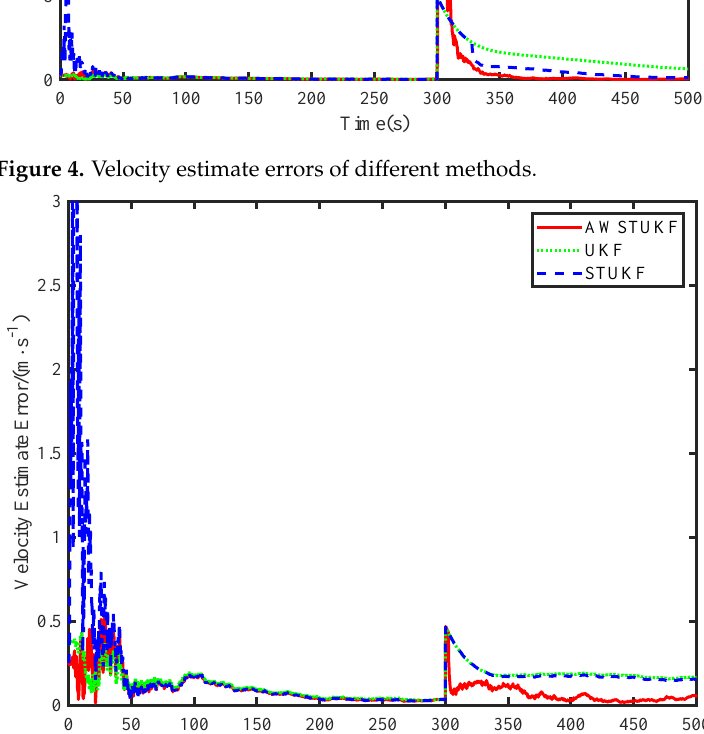
Figure 5. Position estimate errors of different